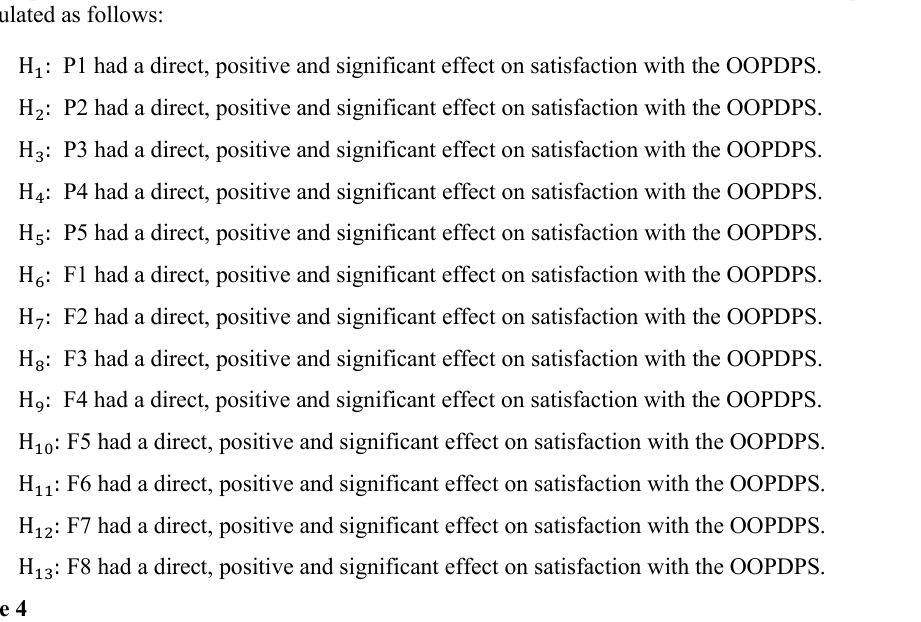
Results of Goodness of Fit Goodness of Fit Measures Fit Criteria Parameter Estimates Description Degree of Freedom